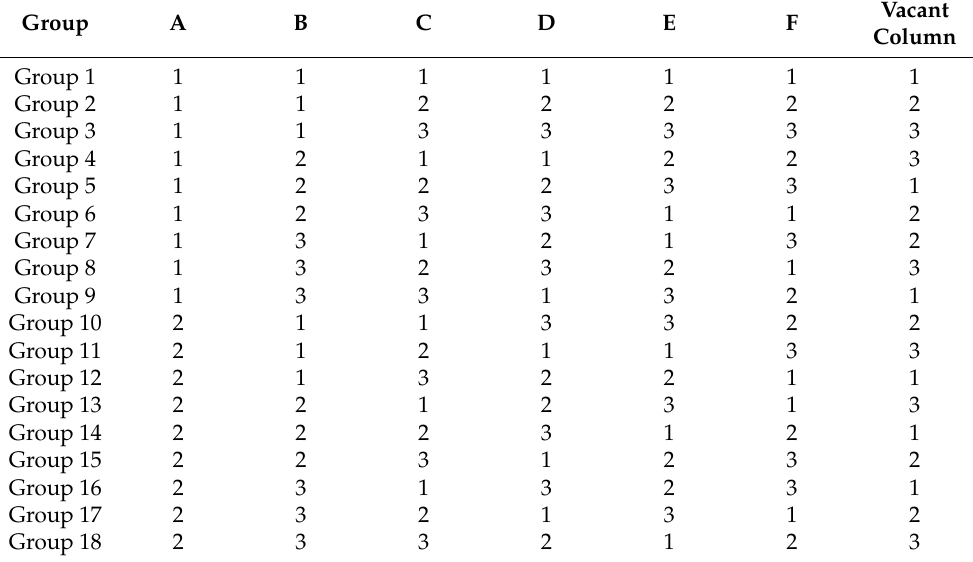
Table 6. L 18 (2 1 × 3 5 ) hybrid orthogonal